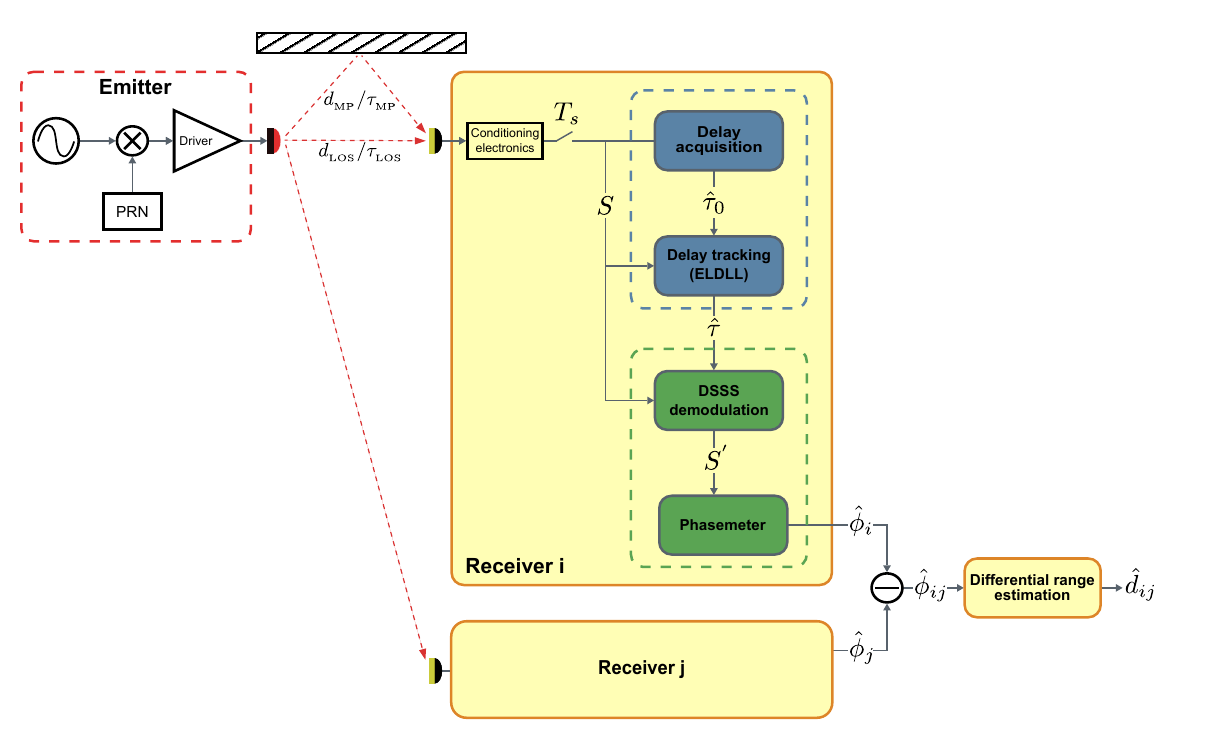
Figure 1. Full diagram of the ranging